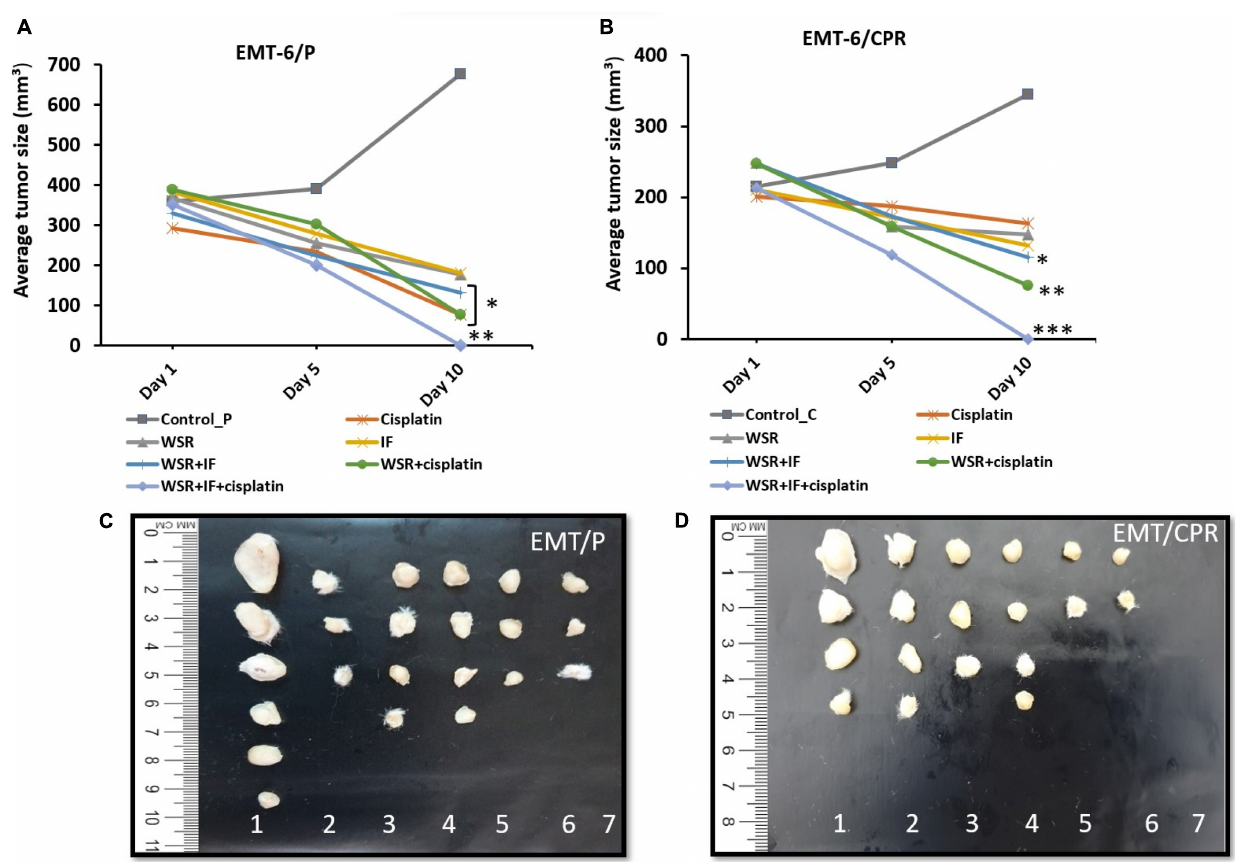
FIGURE 6 | Effect of treatments on tumor size in vivo. (A) A plot of change in average tumor size (mmł) vs. time (days) of treatment in the EMT6/P cell line. (B) A plot of change in average tumor size (mmł) vs. time (days) of treatment in EMT6/CPR cell line. (C) Tumor sizes in EMT6/P cells after dissection on day 10 in all groups compared to each other. (D) Tumor sizes of EMT6/CPR cells after dissection at day 10 in all groups compared to each other. (1 = negative control; 2 = cisplatin; 3 = WSR; 4 = IF; 5 = WSR + IF; 6 = WSR + cisplatin; 7 = WSR + IF + cisplatin). Results are expressed as means ± SEM ( n = 6). ∗ P < 0.05, ∗∗ P = 0.001, ∗∗∗ P < 0.001. ( ∗ : treatment groups compared with the control group).